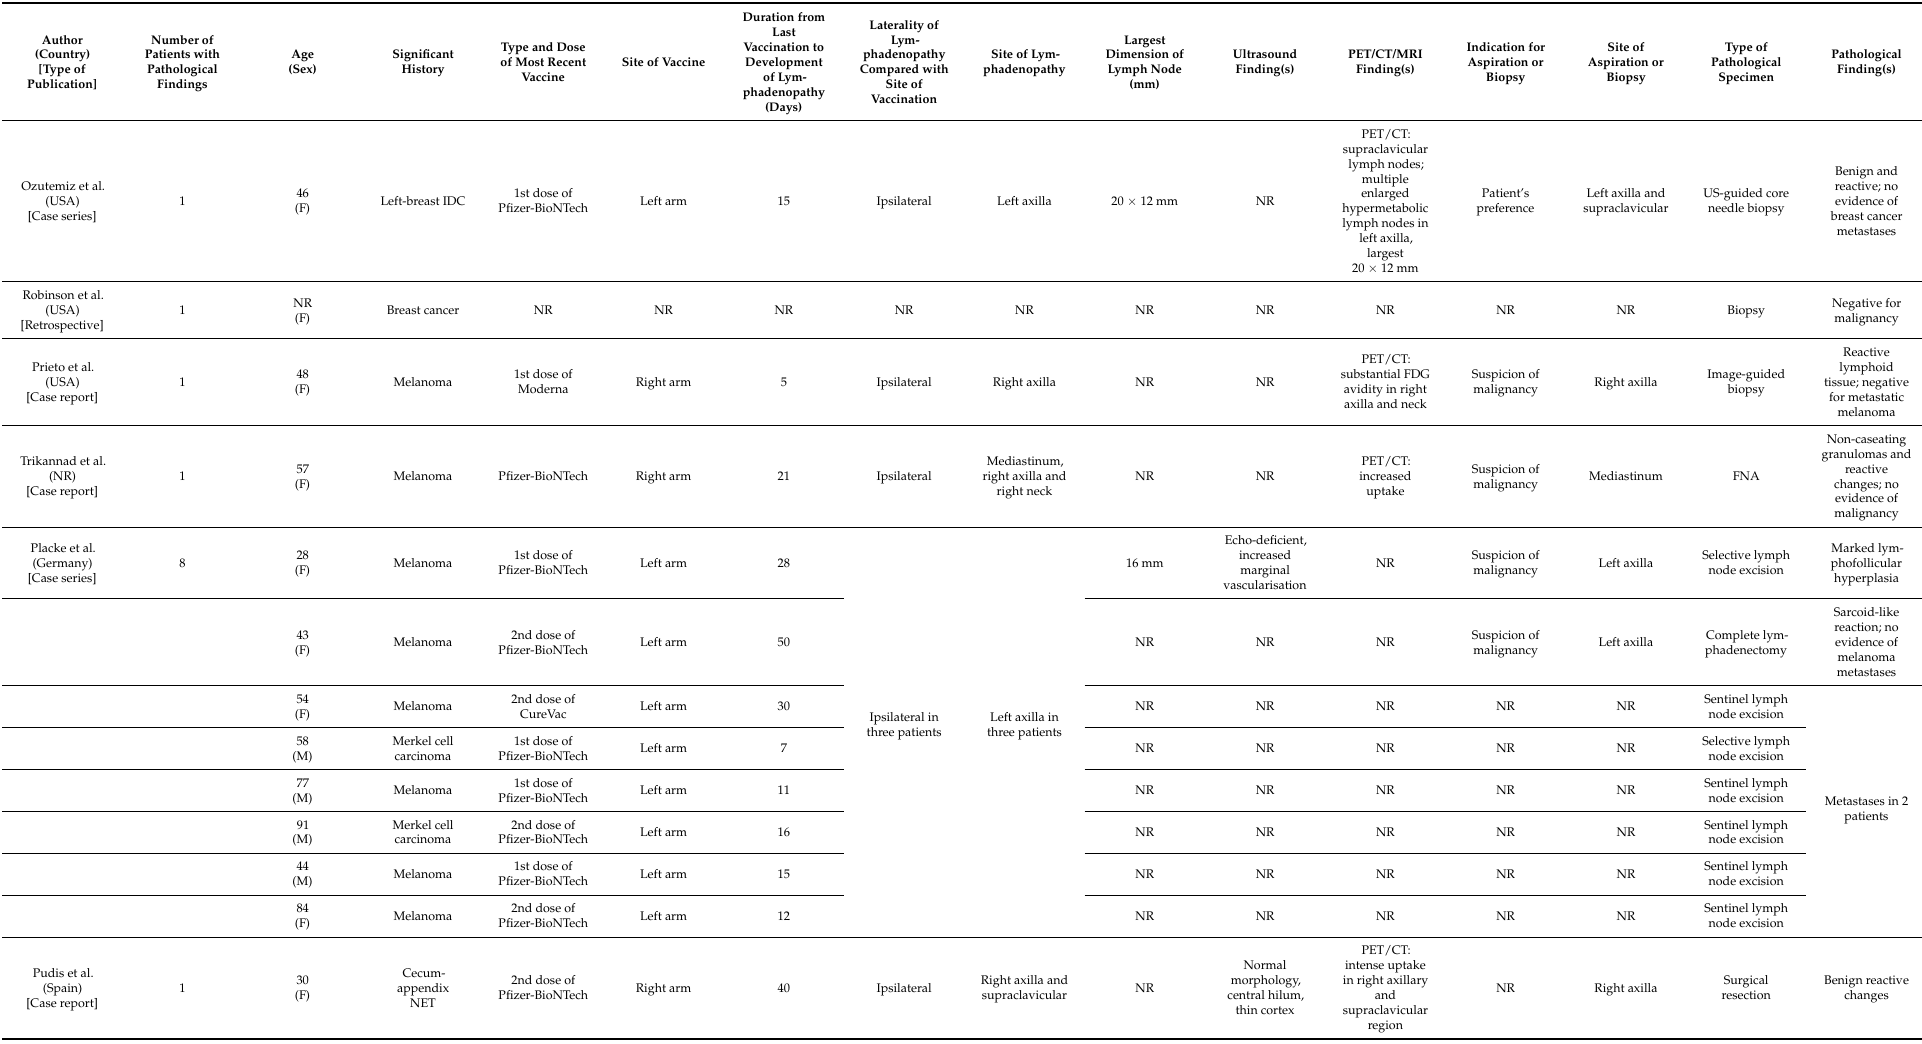
Ipsilateral Rightaxillaand supraclavicular NR